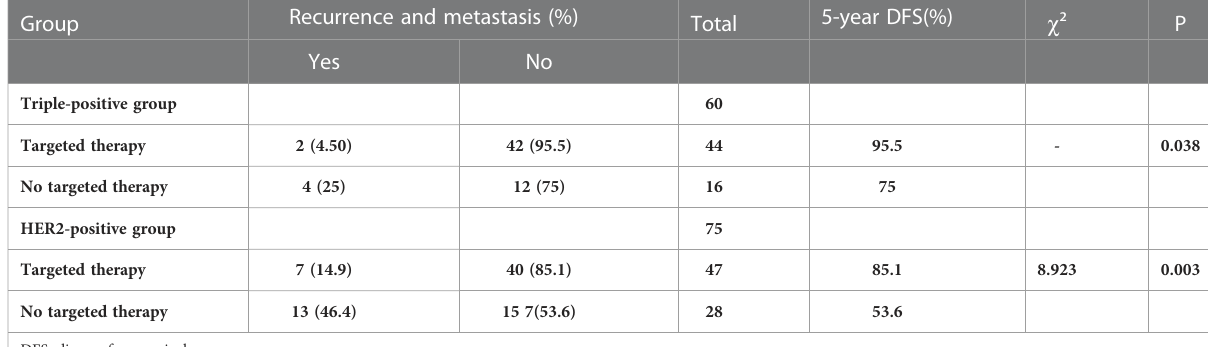
TABLE 5 Recurrence and metastasis with targeted drugs in the triple-positive and HER2-positive groups.